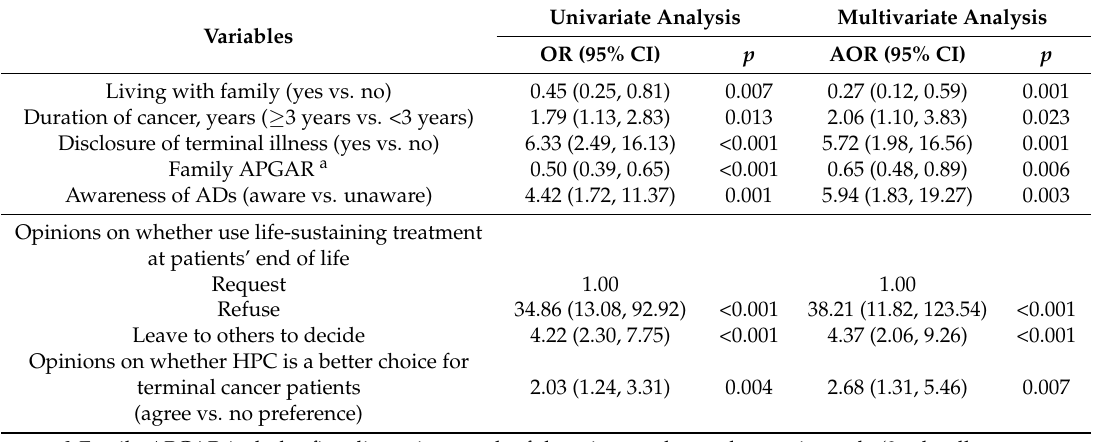
Table 5. Logistic regression analysis of independent predictors of attitudes toward ADs (agree vs.